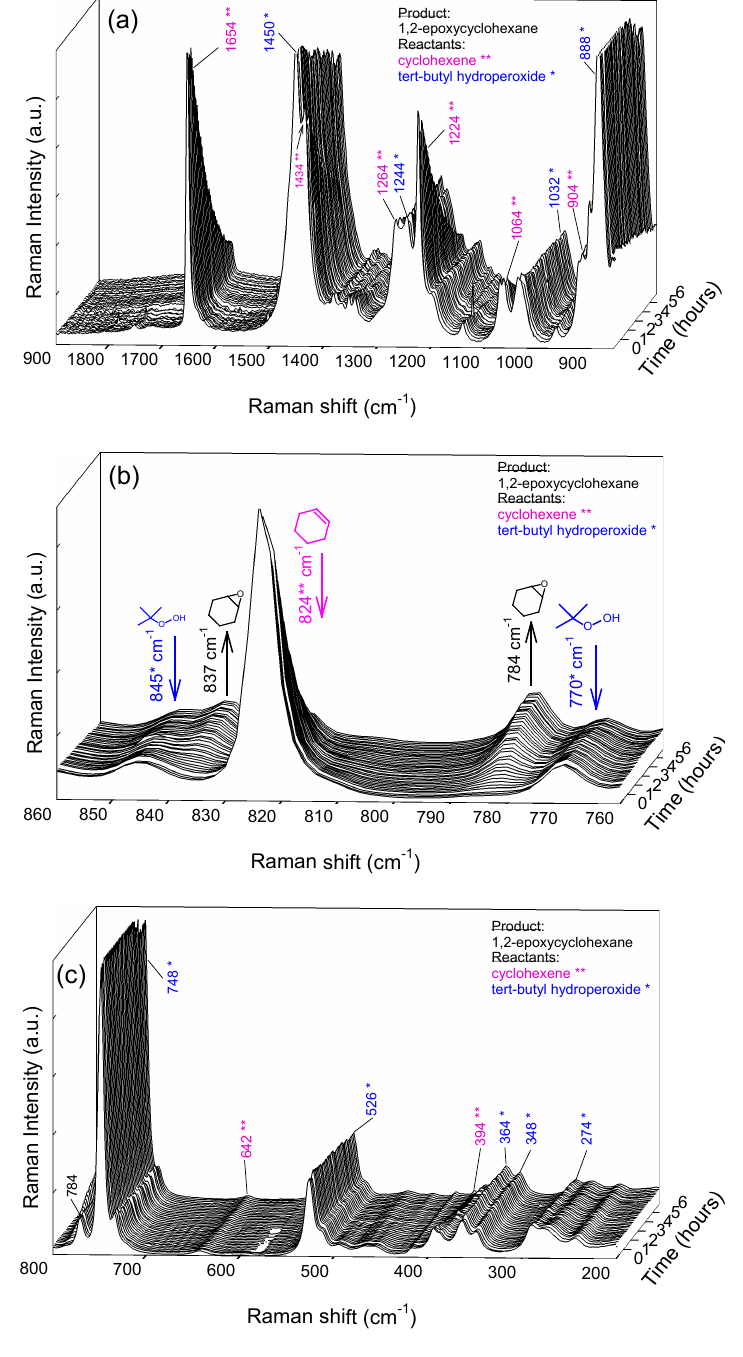
Figure 7. Representative Raman spectral range of ( a ) 1900–860 cm − 1 ; ( b ) 860–760 cm −1